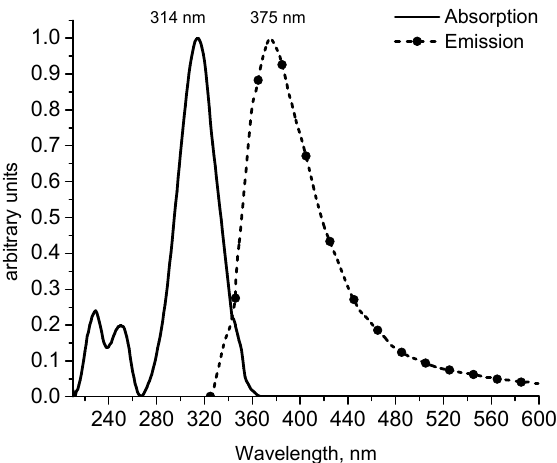
Figure 4. Absorption and emission ( λ ex = 320 nm) spectrum of compound 4 in THF.